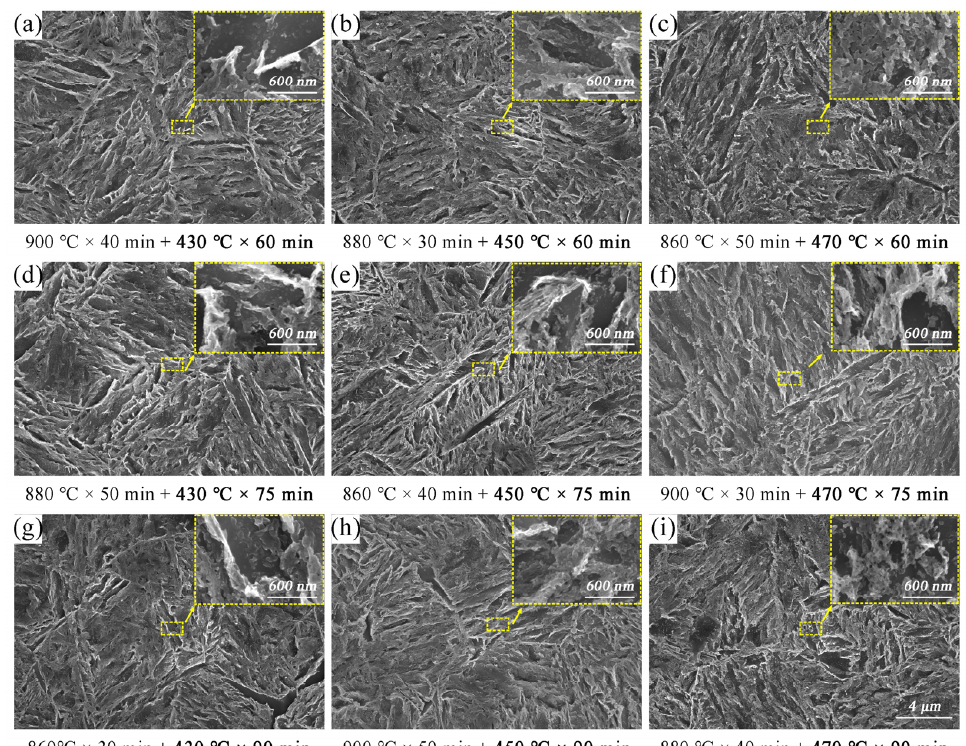
Figure 6. Microstructures corresponding to different tempering conditions: ( a ) No.7; ( b ) No.5; ( c ) No.3; ( d ) No.4; ( e ) No.2; ( f ) No.9; ( g ) No.1; ( h ) No.8; ( i ) No.6.